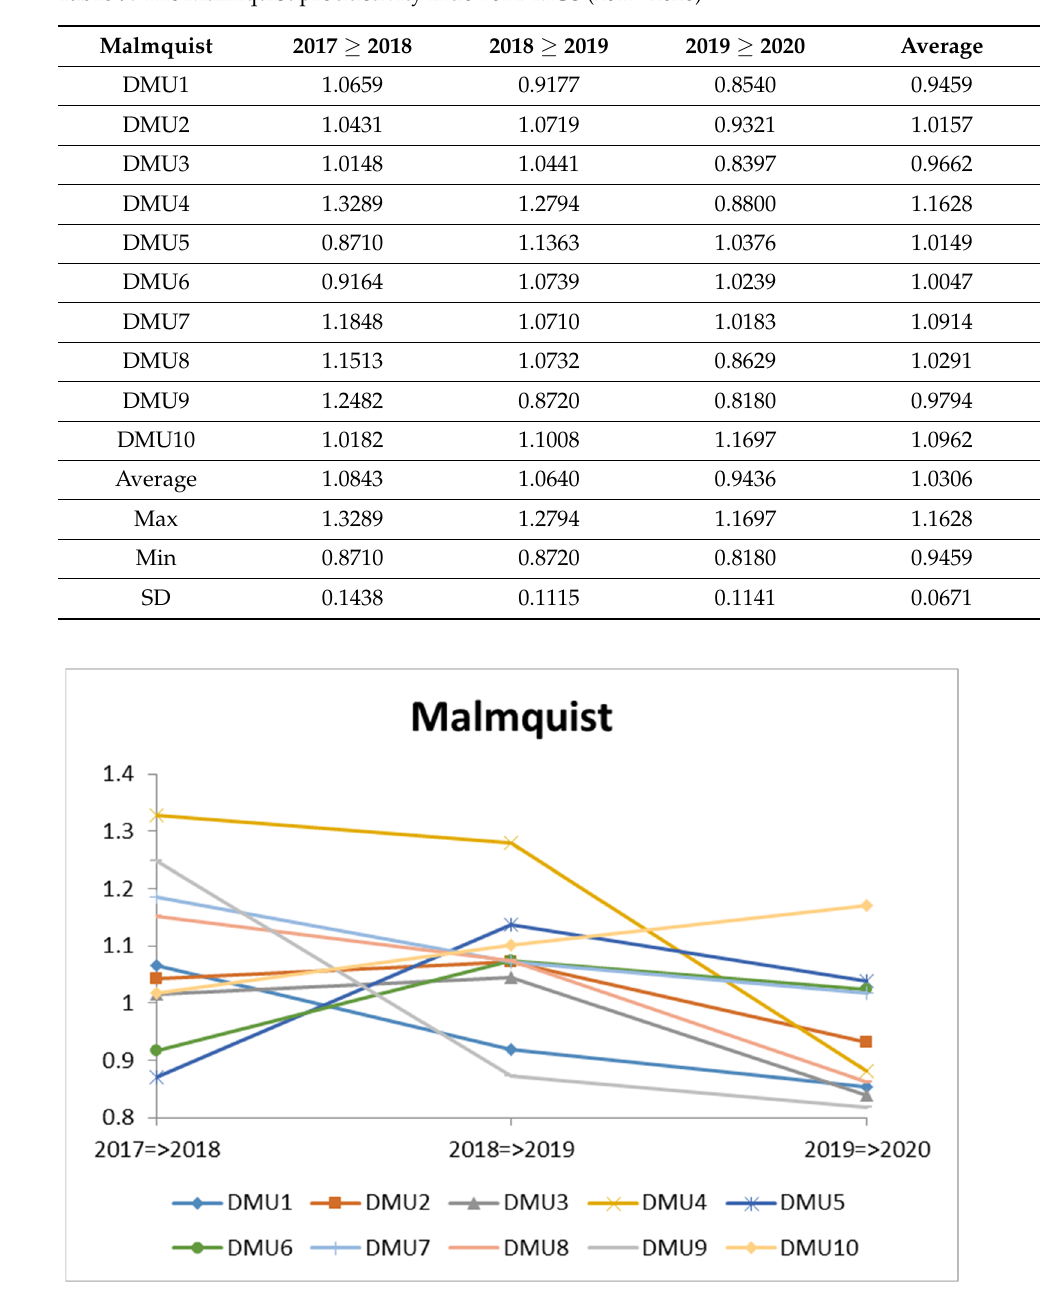
Table 9. The Malmquist productivity index of DMUs (2017–2020).